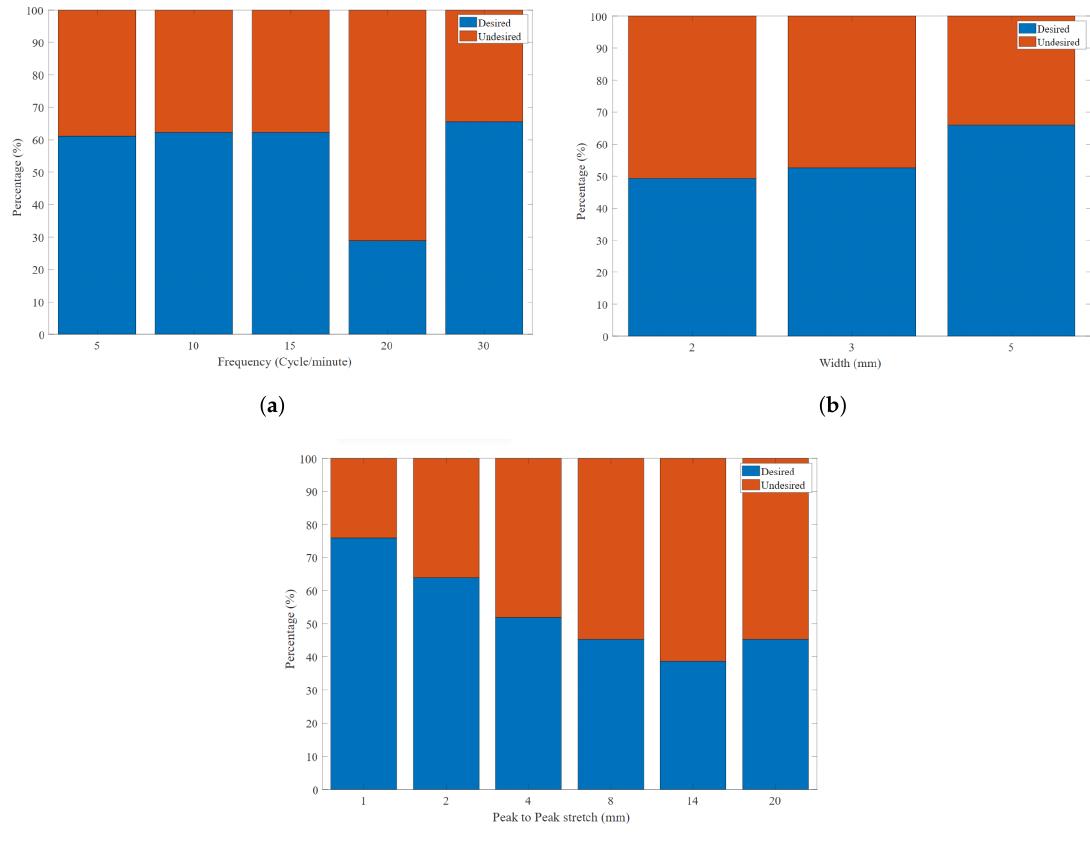
Figure 28. The desired and undesired experiment outcomes for ( a ) each frequency tested ( b ) each band width used ( c ) each stretch amplitude